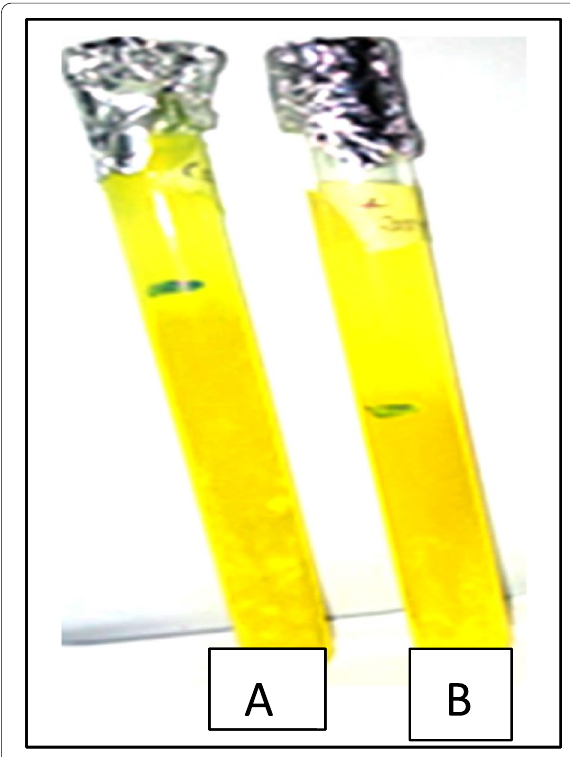
Fig. 8 Amylase activity in juice clarification. A The control sample had little clarification (3 cm). B Better juice clarification with amylase (6 cm)